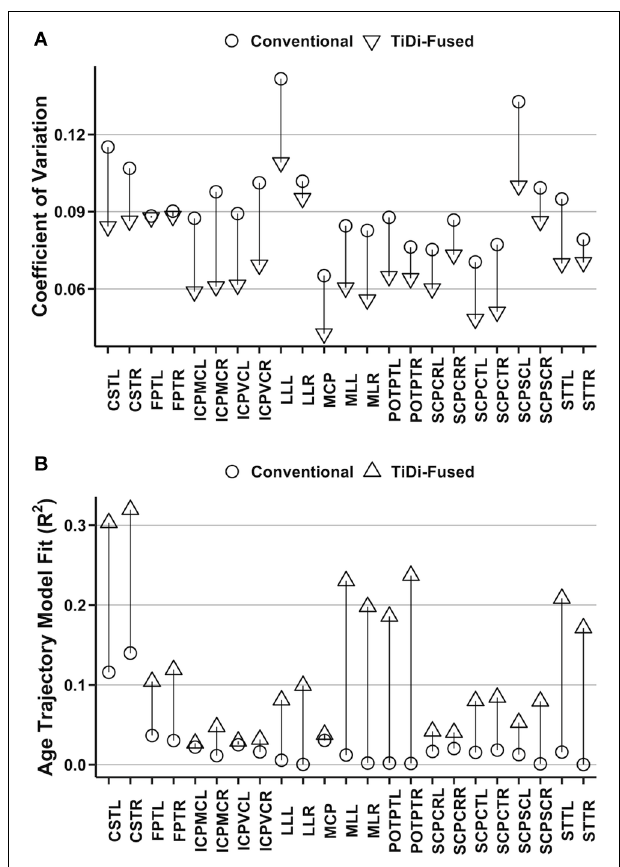
FIGURE 4 | Quantitative analysis of original and optimized pipelines using brainstem white matter regions of interest. (A) Comparison of coefficient of variation in the original and optimized pipelines. (B) Proportion of age trajectory variance (R 2 ) explained by apparent fiber density (AFD) in each white matter